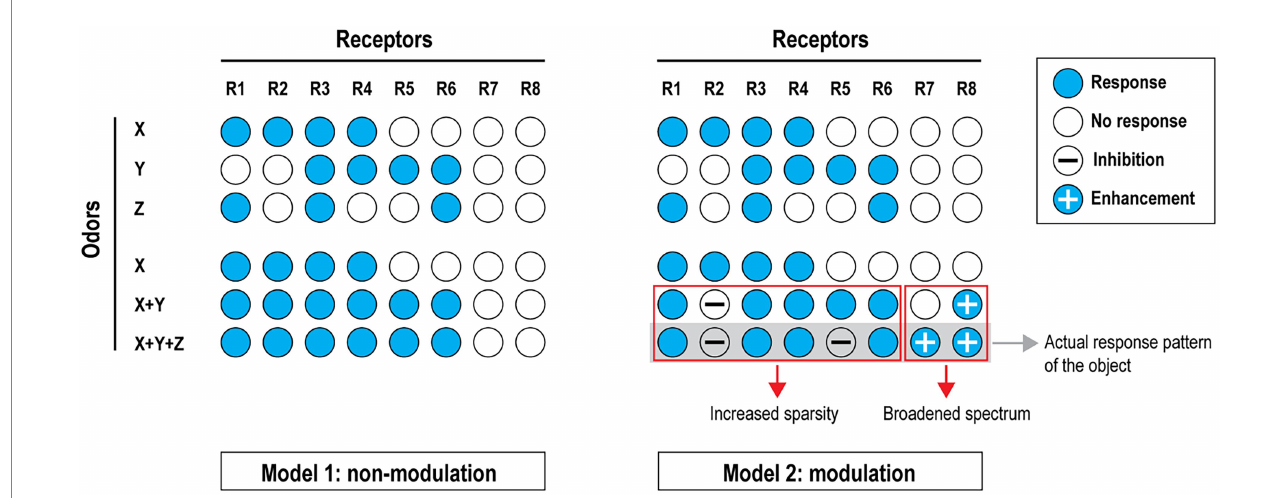
FIGURE 2 Diversified coding capacity through modulation. Two conceptual models are shown to contrast their robustness in odor mixture coding. Non-modulation model (left): Suppose odors X, Y and Z (all monomolecular compounds) can each activate a subset of odor receptors. In this model, mixing odor Y with odor X would recruit two more receptors but adding Z will not produce a different perception, although its response profile only partially overlaps with X and Y. Modulation model (right): In this model, all receptors are subject to modulation in addition to their activation profiles. Under one possible circumstance (similar to what we have observed), mixing odors X and Y results in the inhibition of receptor 2 and the enhancement of receptor 8. Adding odor Z into the mixture inhibits receptor 5 and enhances receptor 7. As a result, the sparsity is increased due to inhibition and the spectrum of odor coding is expanded through enhancement. Together these serve to increase the robustness of pattern detection as a mechanism of perception. This model also implies that ‘silent’ receptors (R7 and R8 in this case) might be as important as the activated ones in pattern recognition of an olfactory object. [Reprinted from Xu et al.